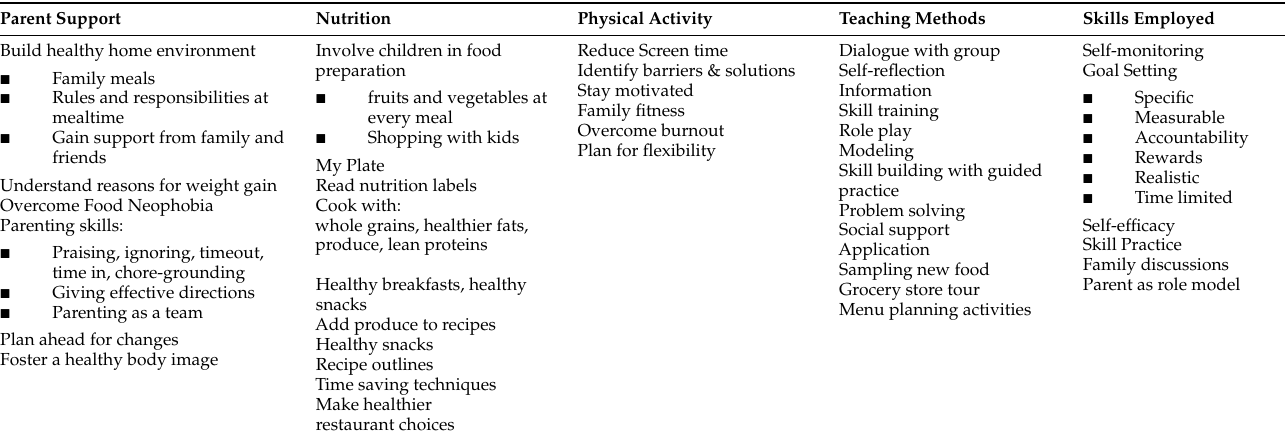
Table 1. Summary of Curriculum